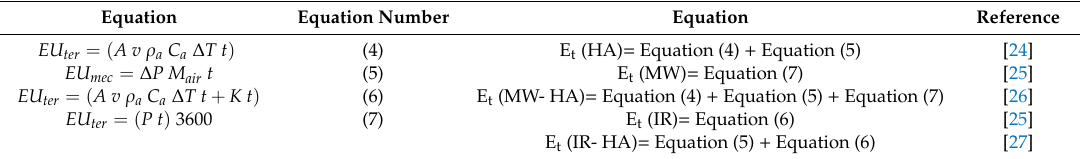
Table 2. Formulas used for determining the energy consumption of di ff erent